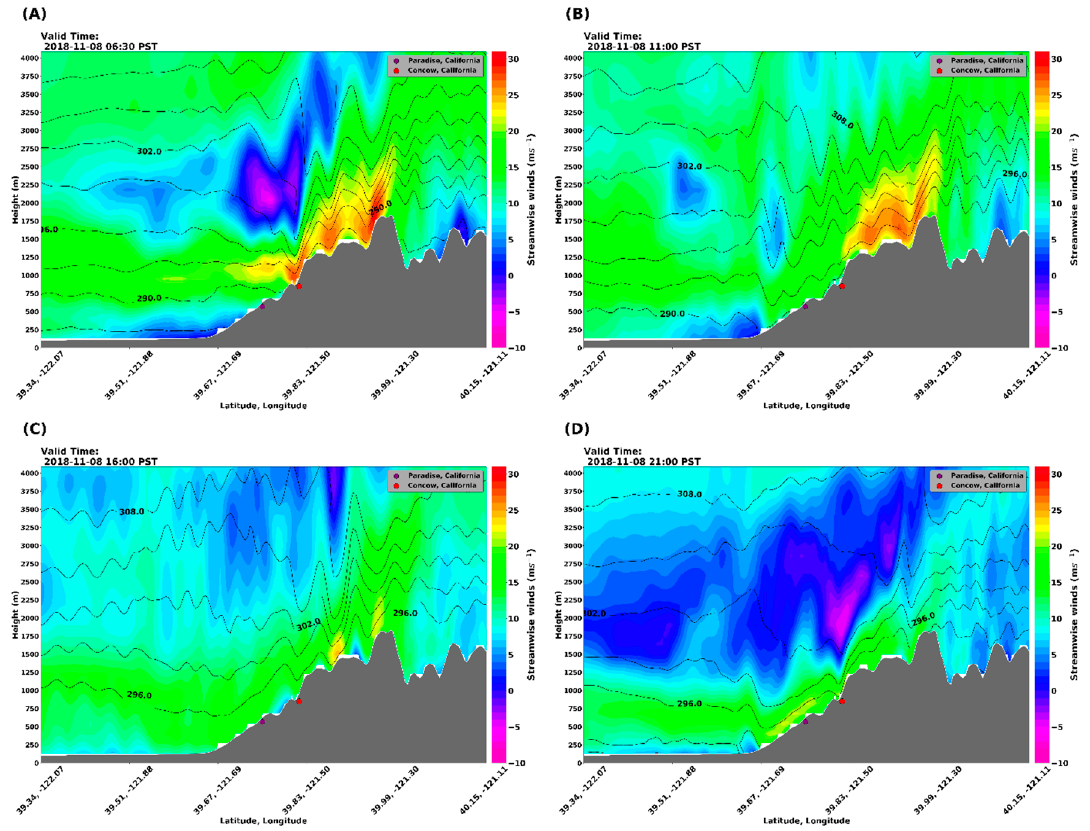
Figure 10. WRF D3, 0.666 km resolution vertical cross sections of streamwise winds (shaded), and potential temperature (contours) at 06:30, 11:00, 16:00, and 21:00 PST 8 November 2018, subplots ( A ), ( B ), ( C ), and ( D ), respectively. The approximate locations of Paradise (hexagon) and Concow (circle) are also shown.